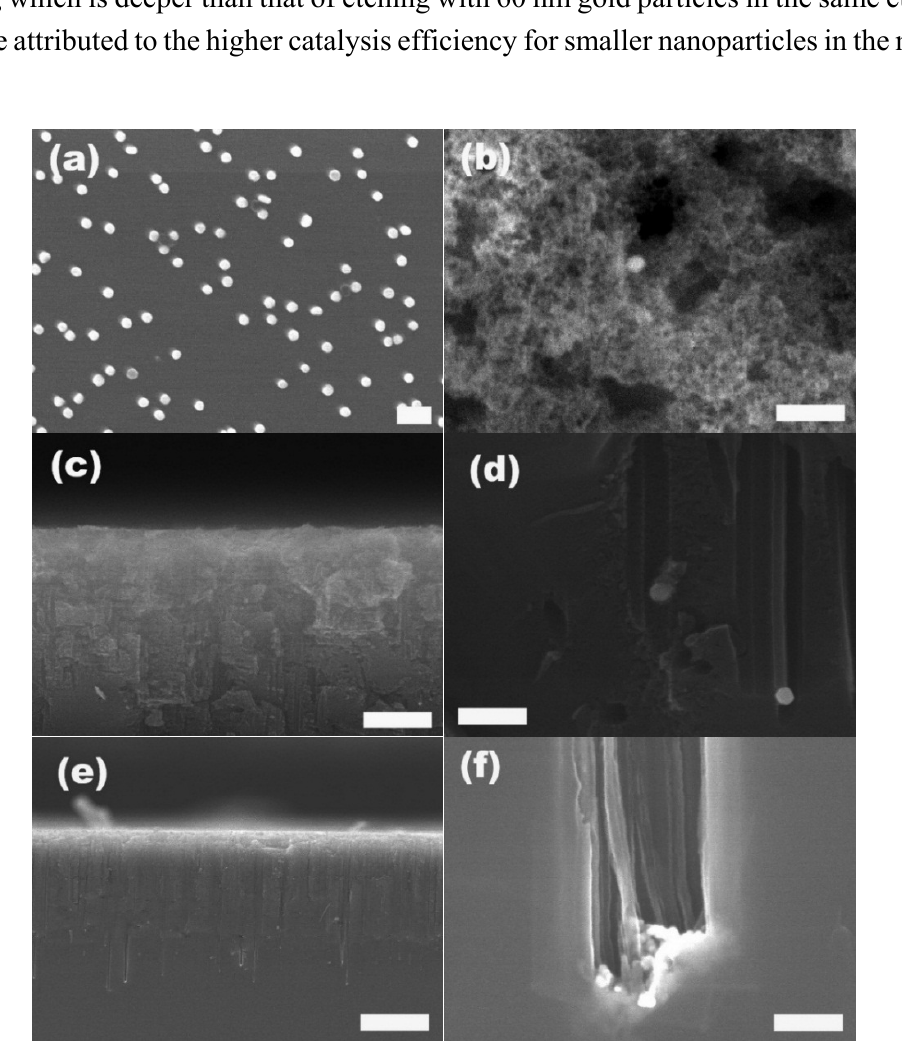
Figure 5. SEM images of S2VP-coated Si immersed in 60 nm gold suspension for 2 h after oxygen plasma etching ( a ), and after etching with HF/H 2 O 2 for 30 mins; ( b ) surface; ( c , d ) cross-section at different magnifications; ( e , f ) cross-section of Si etched with HF/H 2 O